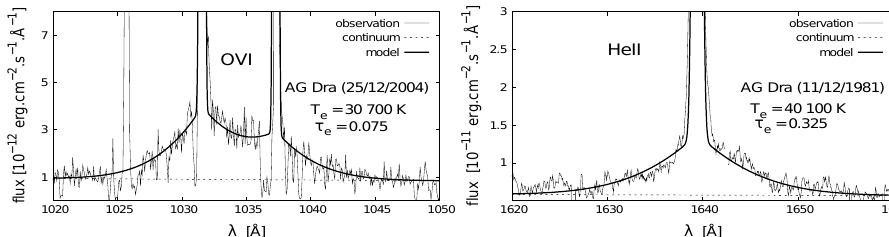
Fig. 1. Comparison of the observed and modeled O VI 1032, 1038 ˚A (left) and He II 1640 ˚A (right) wing profiles in the spectra of the symbiotic star AG